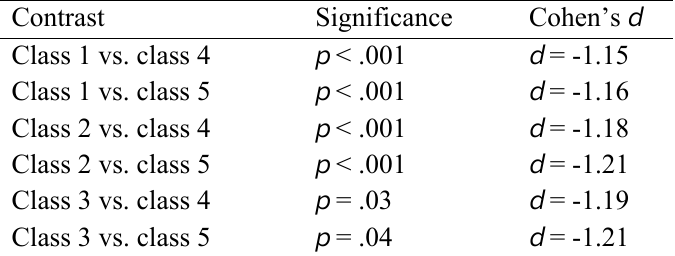
Summary for Significant Post Hoc